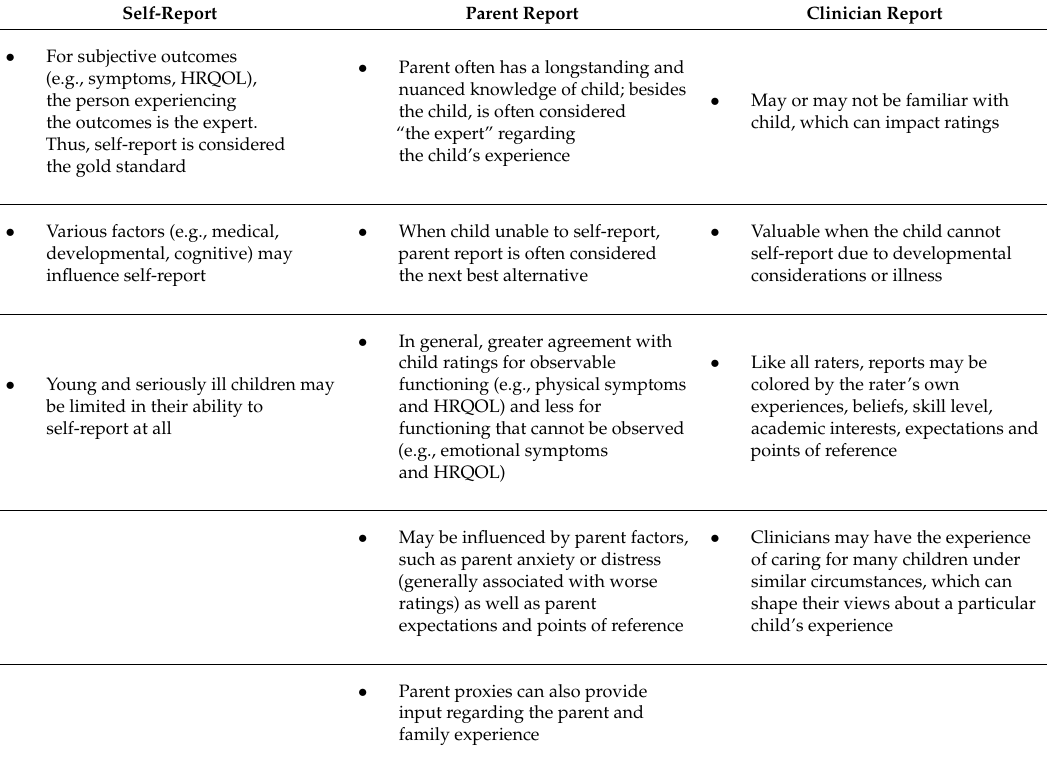
Table 1. Considerations around use of self, parent and clinician report when assessing child symptoms and health-related quality-of-life